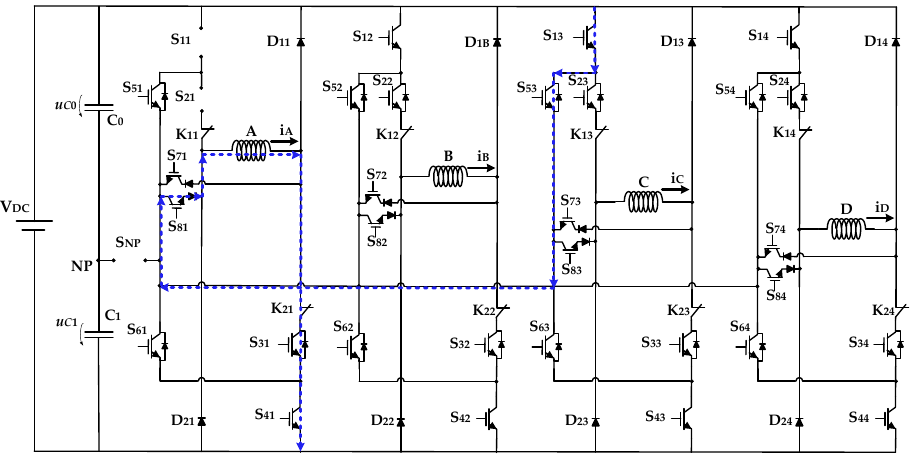
Figure 5. Fault-tolerant solution based on the NPC-AHB topology applied to an 8/6 SRM . Example of a multiple open-circuit fault in power device S 11 and S 21 . A single possible path is available to achieve the full voltage.